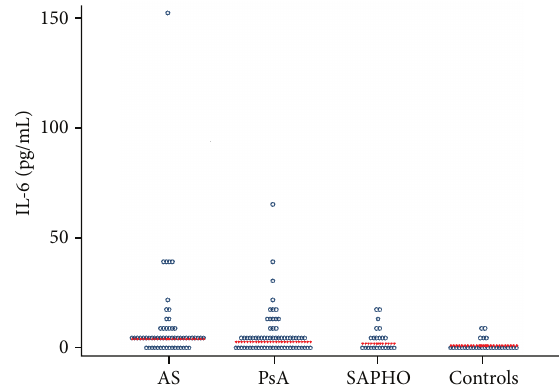
Figure 1: Serum levels of interleukin-6 (IL-6) in patients with psoriatic arthritis (PsA), ankylosing spondylitis (AS), and SAPHO syndrome (SAPHO) and